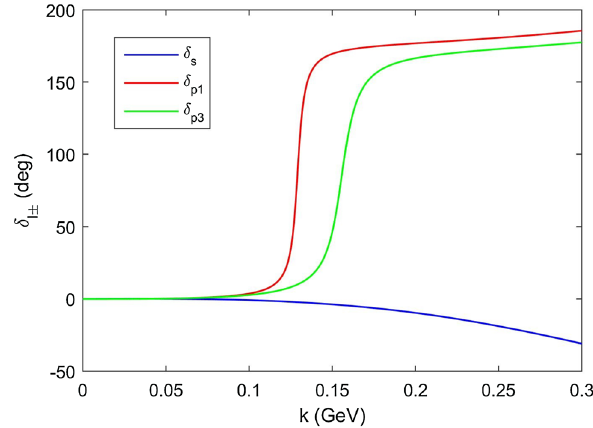
Fig. 4 Phase shifts of the π(cid:2) b interaction